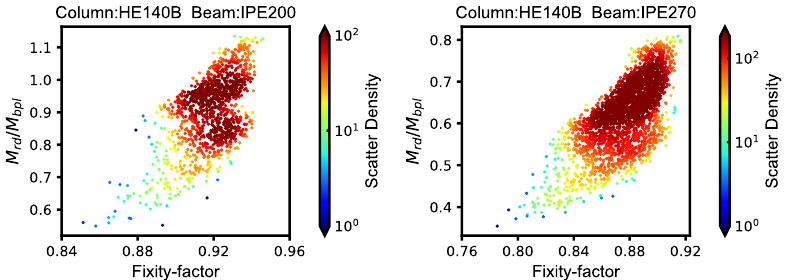
Figure 1. Scatter density diagram of fixity-factor vs. moment coefficient of available joints for specific beam–column in Yin et al. [34].